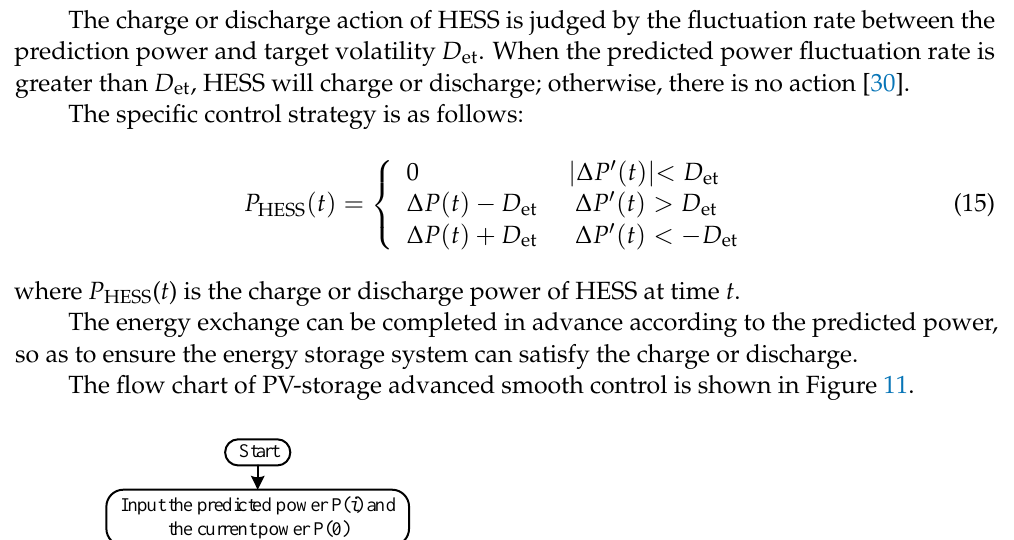
Figure 12. Power smoothing based on the predicted power. As shown in Figure 12, the power smoothing based on the predicted power can ef- fectively solve the problem of the sharp fluctuations within seconds. In combination Fig- ure 8 with Table 1, the relationship between the power smoothing performance and the power prediction accuracy shows that the storage power smoothing performs well when 0 2 4 6 8 10 12 14 16 18 20 22 24 26 28 30 6